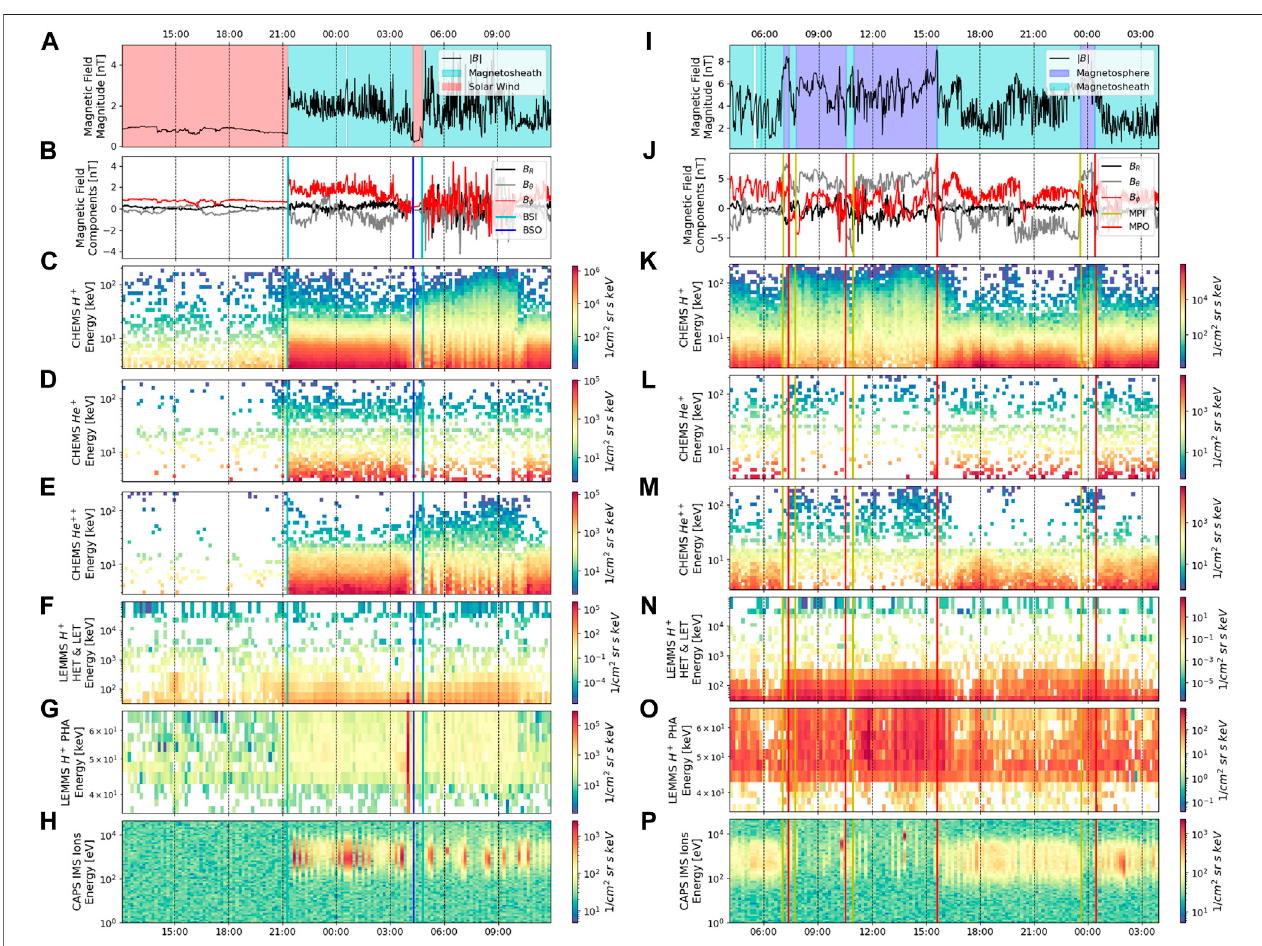
FIGURE 2 | Detailed view of MAG, MIMI CHEMS & LEMMS data, and CAPS/IMS data from two example 24-h periods on 8 March 2008 (left column) and 3 May 2008 (right column) in which the spacecraft passed through the BS and MP, respectively. The regions (magnetosphere, magnetosheath and solar wind) are denoted by shaded bands (A) and (I) , with vertical lines in panels (B – H) and (J – P) denoting the labeled crossings. The MAG data are shown on a 1-min interpolated sampling rate, while all other data are shown on a 10-min interpolated sampling rate. The only data shown from CAPS, CHEMS, and LEMMS are those utilized by the ML algorithms, and speci fi cally spans targeted energy ranges of H + , He + and He ++ ions.